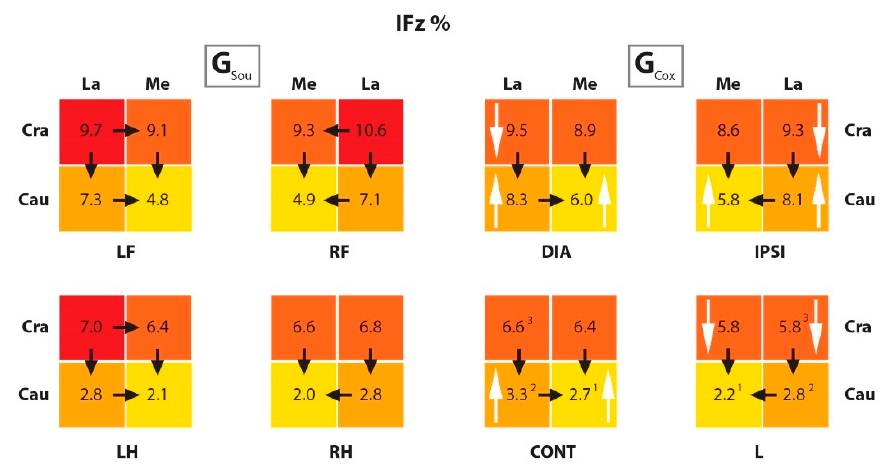
Figure 6. The scheme representing the IFz% in quadrants of the paws from G Sou and G Cox . The black arrows show a significant di ff erence between the quadrants within paws (for example, in the LF limb from G Sou there was a di ff erence between the CraLa and CraMe quadrants); the white arrows, between groups (for example, there was a di ff erence between the CraLa quadrants from the LF limb in G Sou and DIA limb in G Cox ); and the numbers ( 1 2 3 ), between equivalent quadrants in di ff erent limbs within a group (for example, in the G Cox , there was a di ff erence between the CauMe quadrants from the CONT and L limbs). The color scale within paws: higher values in darker colors and lower values in lighter colors. IFz% (vertical impulse normalized as percentual to the total force); G Sou (group sound); G Cox (group coxarthrosis); LF (left front limb); RF (right front limb); LH (left hind limb); RH (right hind limb); DIA (diagonal limb); IPSI (ipsilateral limb); CONT (contralateral limb); L (lame limb); Cra (cranio); La (lateral); Cau (caudo); Me (medial).